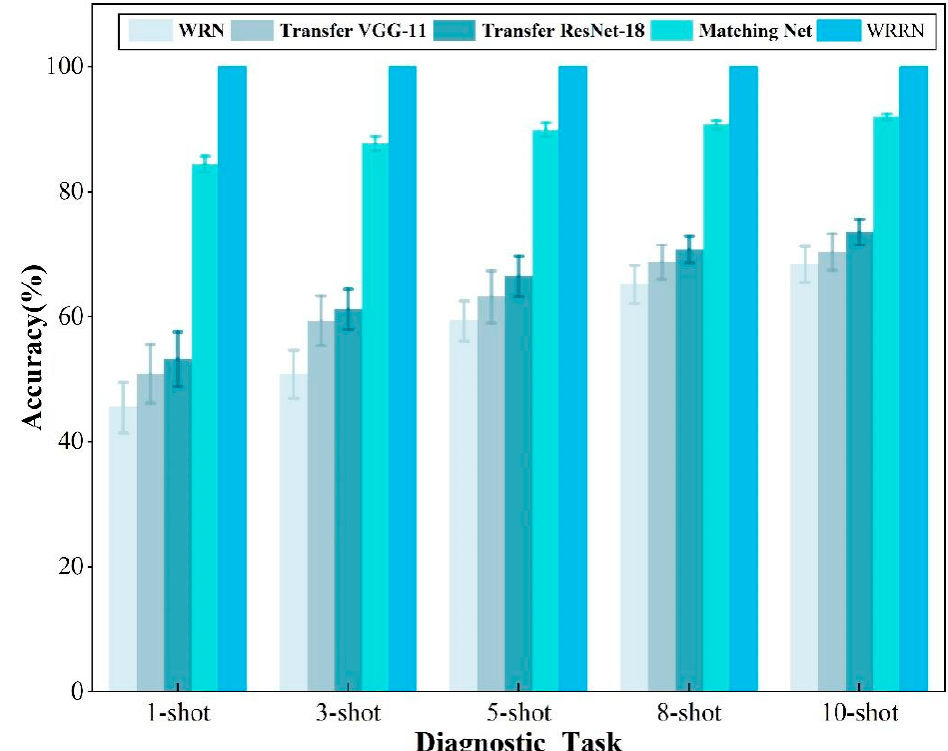
Figure 8. Accuracy comparison results of different methods on task A5.